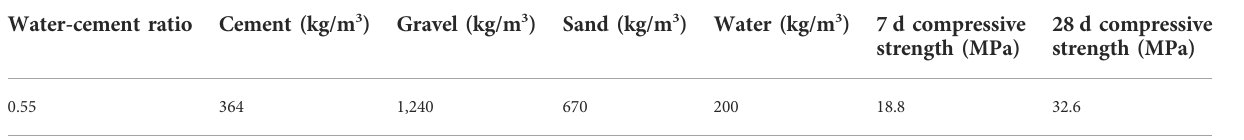
TABLE 4 Concrete mix proportions and mechanical properties.